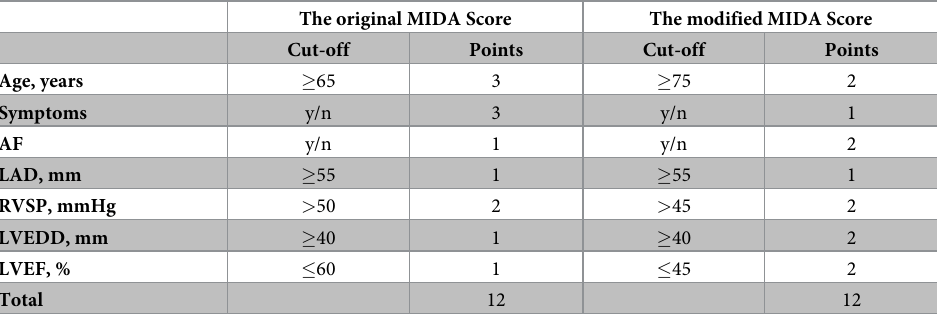
Table 3. Detailed presentation of the difference between the original and modified MIDA score.